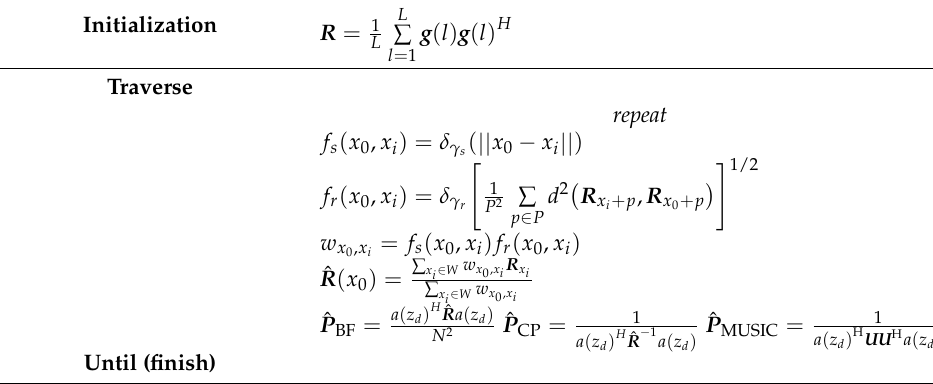
Table 1. Details of the classical spectral estimators based on NLM. Initialization